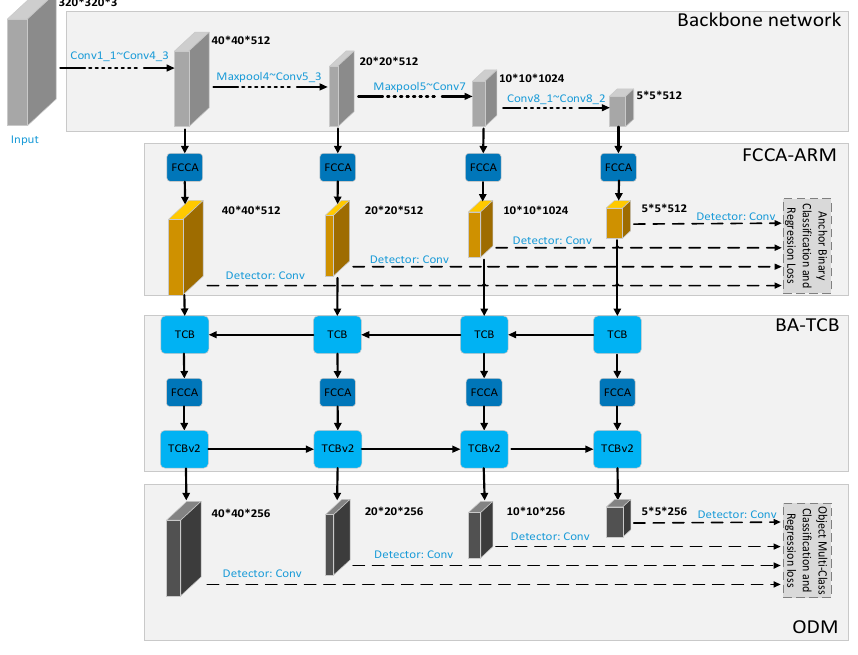
Figure 2. The network architecture of the proposed method.